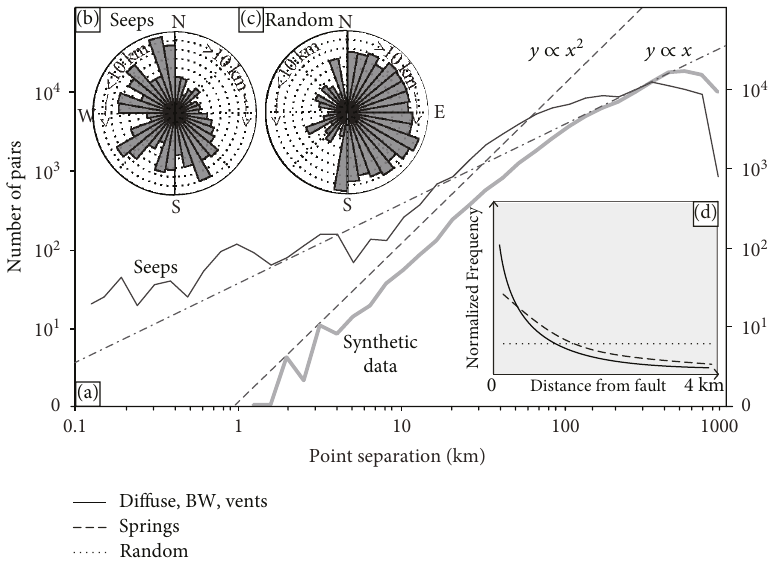
Figure 2: (a) Point-distance correlation functions for seep and synthetic (random) data in mainland Italy, showing the break in the slope for seep data around ~ 5 km and roll-o ff towards ~ 100 km in both datasets. The synthetic dataset is not clustered so few pairs are < 10km apart. Inset shows distribution of azimuths for points < 10 km (anticlockwise) and > 10 km (clockwise) for (b) seeps and (c) synthetic data. Seeps show several favored orientations < 10 km and NW-SE trend > 10km separation. (d) Normalized line histogram of seep types and distances from lithological boundaries and faults. BW refers to bubbling water